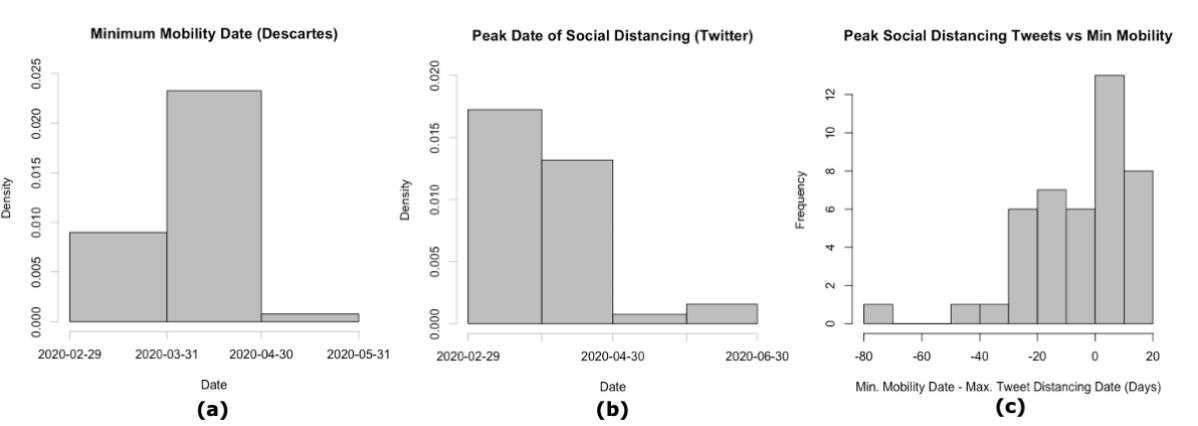
Figure 5. Comparison of peak social distancing tweet proportions and minimum mobility. To validate our social media findings, we compared them to mobility data provided by Descartes Labs. Dates of minimum mobility are aggregated by month (a), while dates of highest proportion of tweets about social distancing, aggregated by month, are shown in (b). The difference, in days, between the date of minimum mobility and the date of highest proportion of social distancing tweets (c) show that most states observed both peaks within 20 days of one another.